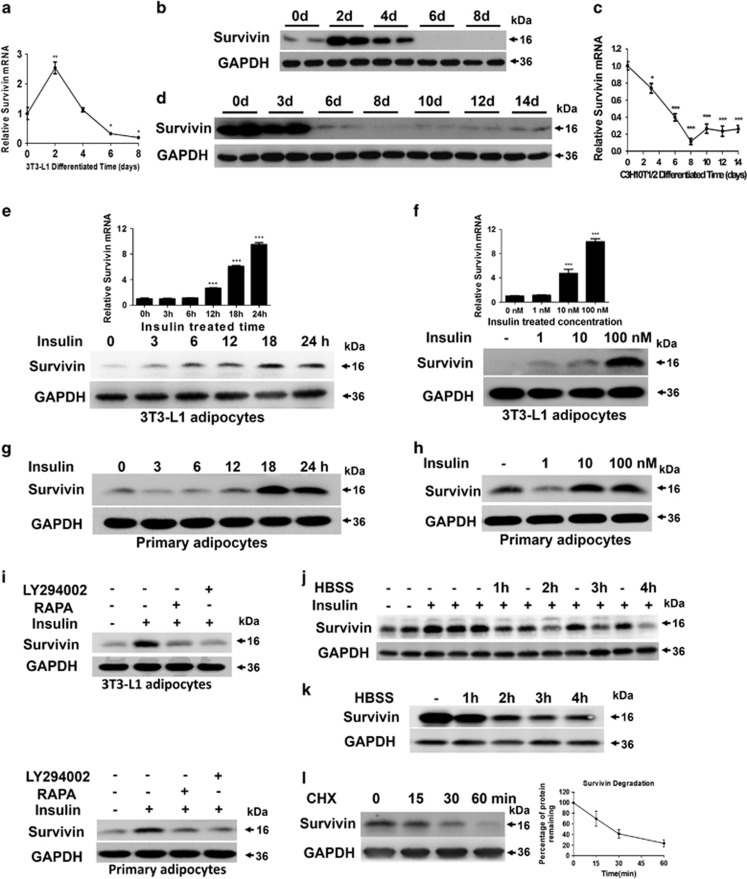
Survivin is expressed upon insulin exposure through the PI3K/mTOR pathway in mature adipocytes. During the differentiation process of 3T3-L1 cells and C3H10T1/2 cells, Survivin mRNA and protein levels were determined by qRT-PCR (a and c) and western blot (b and d). Survivin expression was detected by qRT-PCR and western blot in 3T3-L1 adipocytes, which were treated with 100 nM insulin for the indicated time (e) and insulin at the indicated concentrations for 24 h (f). Primary adipocytes, isolated and cultured from the SVF of subcutaneous fat, were induced to differentiate into mature adipocytes. Then Survivin content was determined by western blot after treating with 100 nM insulin for the indicated time (g) and insulin at the indicated concentrations for 24 h (h). Survivin content was immunobloted after rapamycin (10 nM) and LY294002 (50 μM) for one hour prior to insulin exposure (100 nM) both in 3T3-L1 adipocytes and primary adipocytes (i). (j) 3T3-L1 adipocytes were incubated with insulin (100 nM) for 24 h, then incubated with or without HBSS for the indicated time. Immunoblots determined the levels of Survivin and GAPDH. (k) Protein levels of Survivin were detected by western blot in 3T3-L1 adipocyte overexpressing Survivin after incubation with HBSS for the indicated time. (l) The stability of ectopic expression of Survivin was evaluated in a cycloheximide (CHX, 100 μg/ml) chasing experiment. Cells were harvested 0, 15, 30 or 60 min after the addition of CHX. The ectopic expression of Survivin protein level was evaluated using western blot. *P<0.05, **P<0.01, ***P<0.001